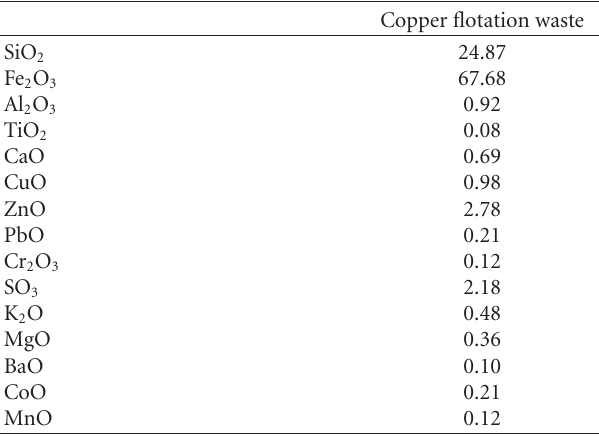
Table 1: Chemical composition (wt. %) of copper flotation waste. Table 2: The levels of experimental factors for the full factorial